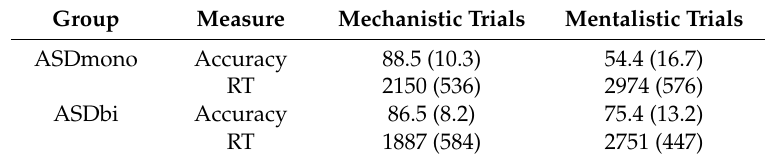
Table 10. Groups’ mean accuracy scores and RT in the low-verbal Theory of Mind task. Group Measure